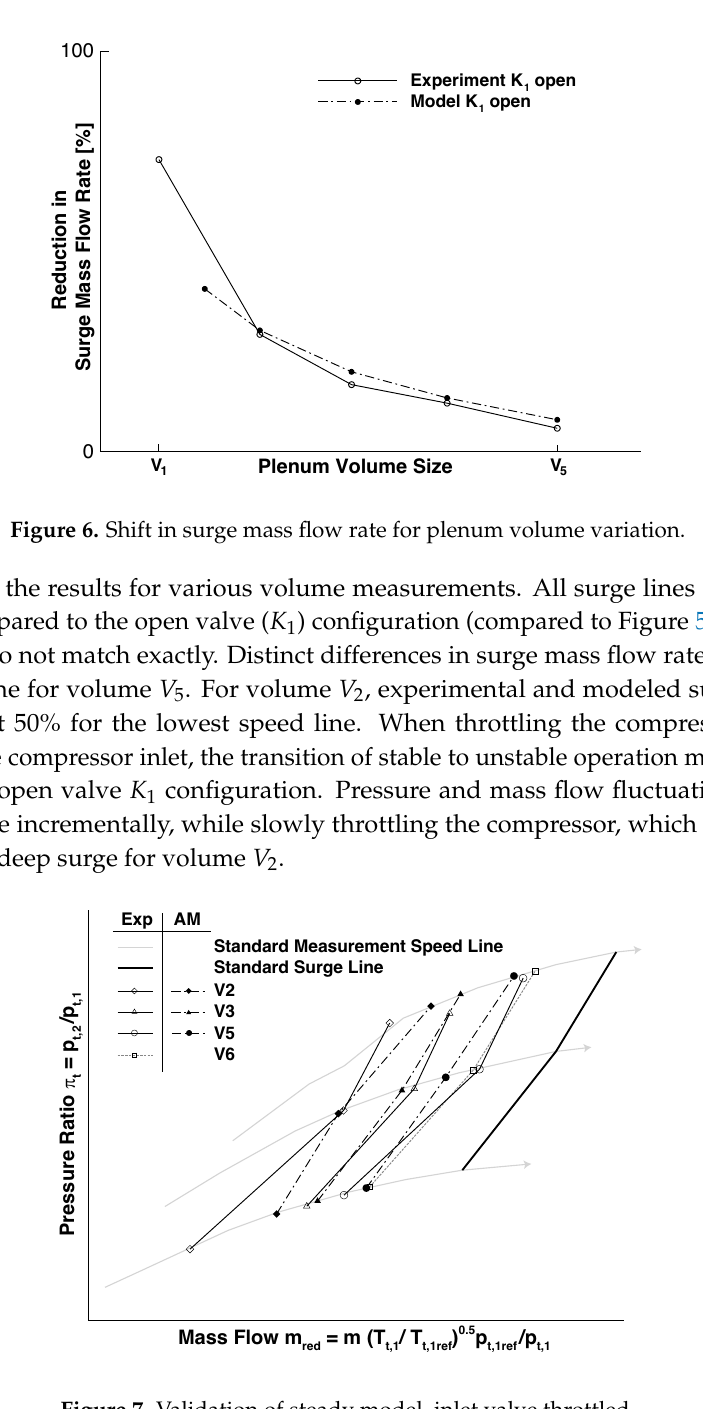
Figure 7. Validation of steady model, inlet valve